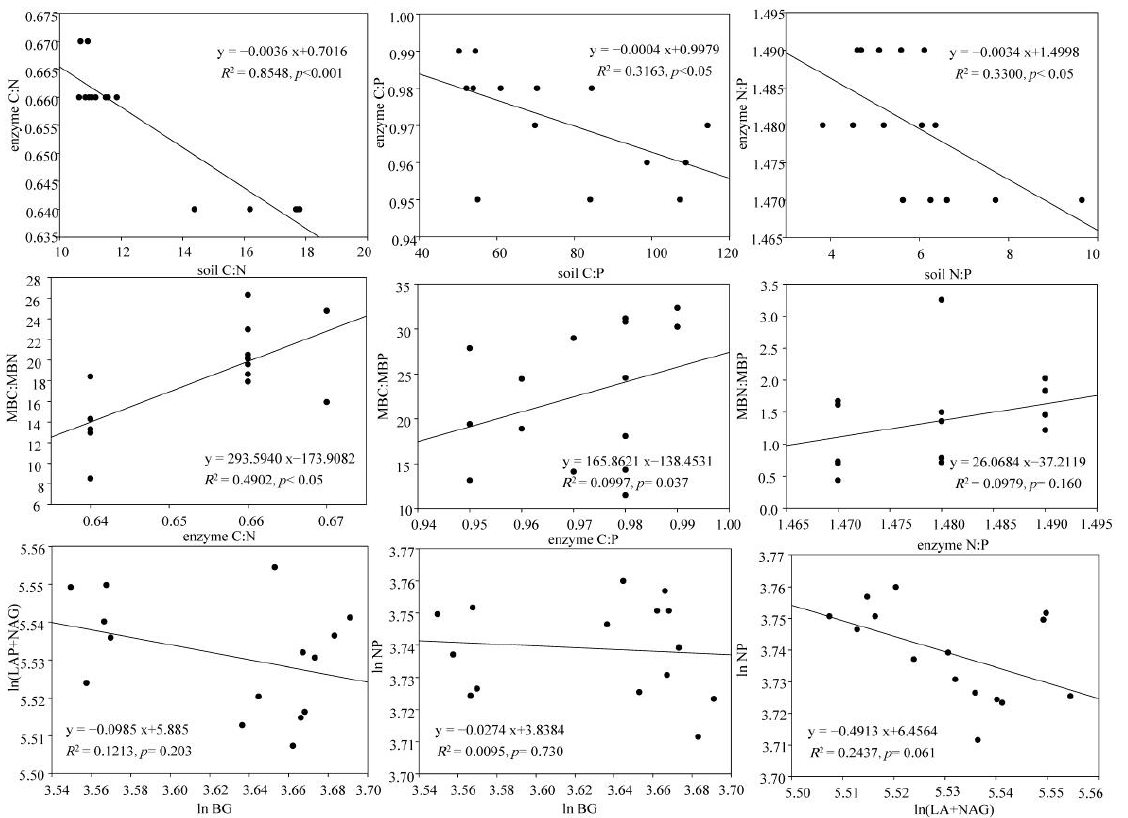
Figure 2. Correlation analysis of soil extracellular enzyme stoichiometry with soil C, N and P or microbial biomass C, N and P stoichiometry.